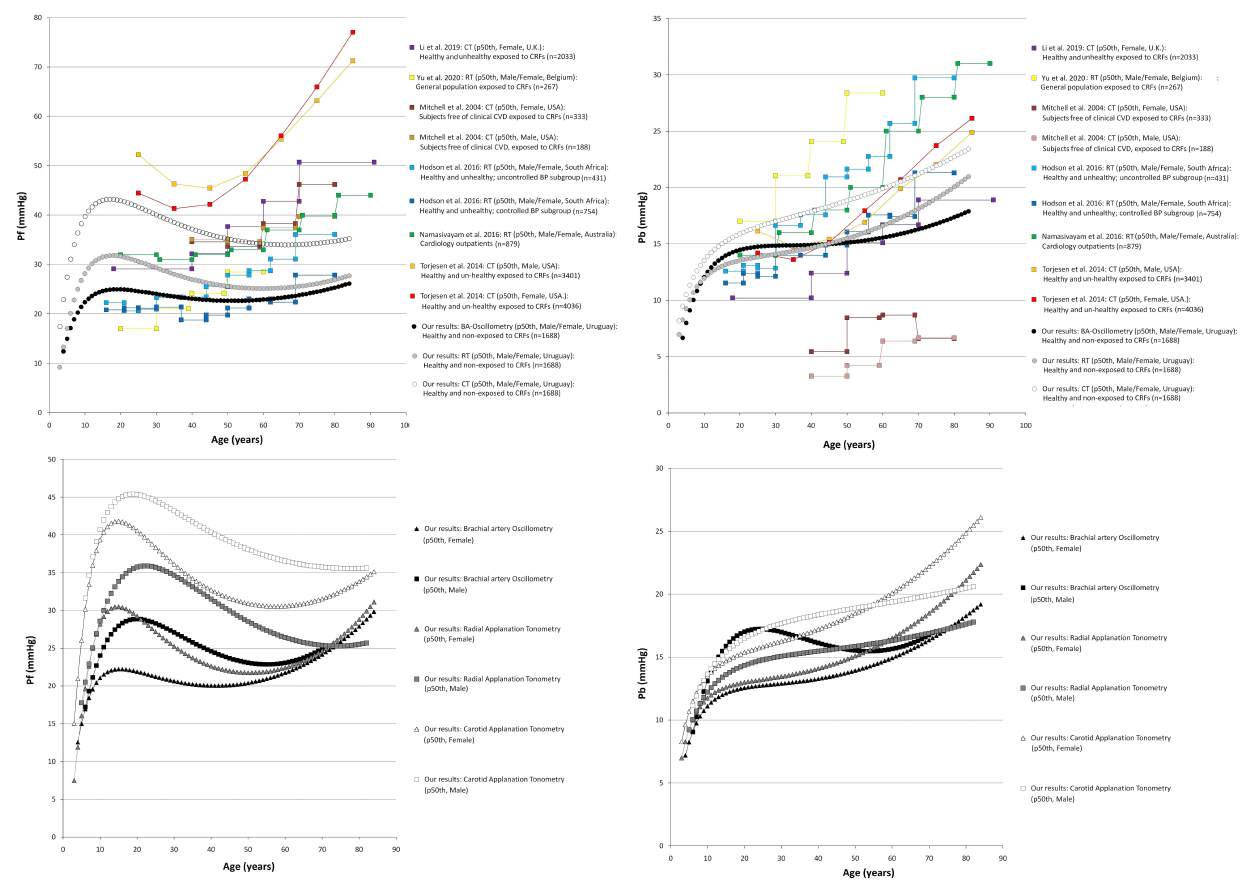
FIGURE 3 | Forward pressure (Pf) and backward pressure (Pb) age-related profiles. Top: Comparison between curves obtained in our study (p50th) and mean values or p50th obtained by other authors. CT, carotid applanation tonometry; CRFs, cardiovascular risk factors; RT, radial applanation tonometry; U.K., United Kingdom; United States, United States of America; BP, blood pressure; BA, brachial artery; Bottom: Age-related profiles (p50th) for males and